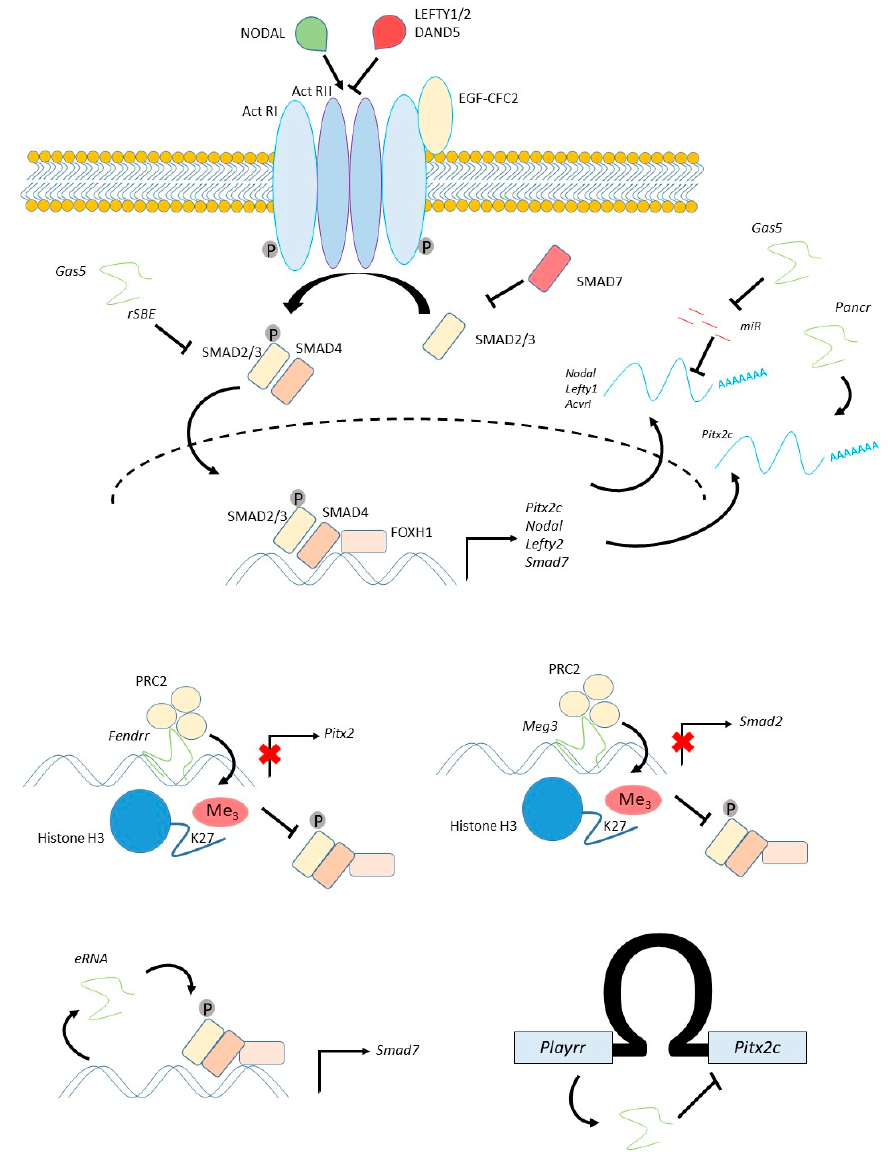
Figure 2. Long non-coding RNA acting within the NODAL signalling pathway. The TGF β family protein NODAL (green) binds to a transmembrane receptor (ActRI, ActRII). Binding requires the co-factor EGF-CFC2 and can be inhibited by LEFTY1 / 2 or DAND5 (red). Receptor activation leads to phosphorylation of SMAD2 / 3, which recruits SMAD4 and translocates across the nuclear membrane (dashed line). SMAD2 / 3 can be inhibited by SMAD7. The SMAD2 / 3 / 4 complex binds DNA in cooperation with tissue-specific transcription factors such as FOXH1, leading to transcription of target genes including Pitx2c, Nodal, Lefty2 and Smad7 . mRNA are indicated in the diagram in blue, while long non-coding RNA (lncRNA) are indicated in green and miRNA in red. Cytoplasmic lncRNA known to regulate NODAL pathway genes include Gas5 (growth arrest specific), which can bind to and inhibit SMADs through its RNA SMAD binding element (rSBE) or act as an endogenous competitor to inhibit miRNAs targeting Nodal, Lefty2 or Acvr1 . Nuclear lncRNA are illustrated in the lower part of the diagram. Fendrr (fetal-lethal noncoding developmental regulatory RNA) can recruit PRC2 (polycomb repressive complex 2) to the Pitx2 locus, leading to trimethylation of histone H3 lysine 27. This inhibits binding by SMAD2 / 3 / 4 and prevents transcription. Meg3 (maternal expressed gene) similarly recruits PRC2 to the Smad2 locus. Smad7 expression is regulated by an enhancer RNA (eRNA) which promotes expression. Playrr (Pitx2 locus-asymmetric regulated RNA) mediates a chromatin-looping mechanism to regulate Pitx2 expression.